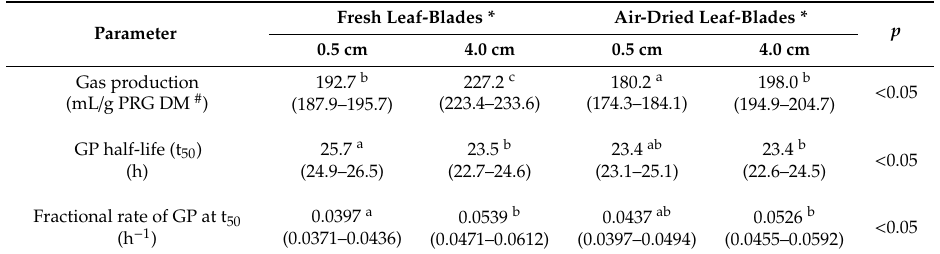
Table 3. E ff ect of perennial ryegrass (PRG) condition (fresh or air-dried) on N. frontalis fitted total gas production (GP) data and derived parameters at two di ff erent leaf-blade